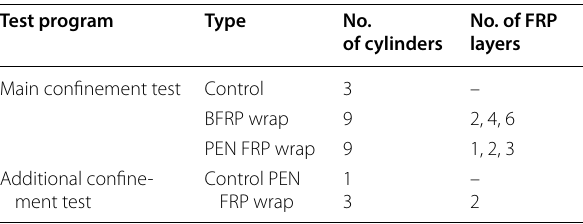
Table 4 Type and number of tests: main and additional confinement tests.